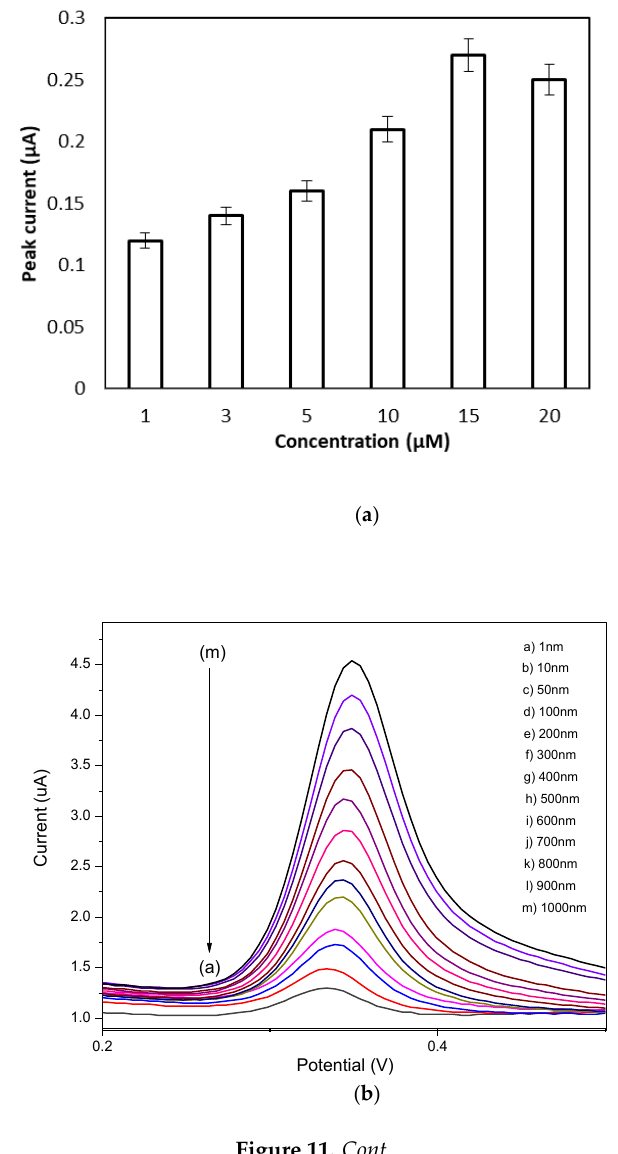
Figure 11 . Cont . Figure 11. Cont